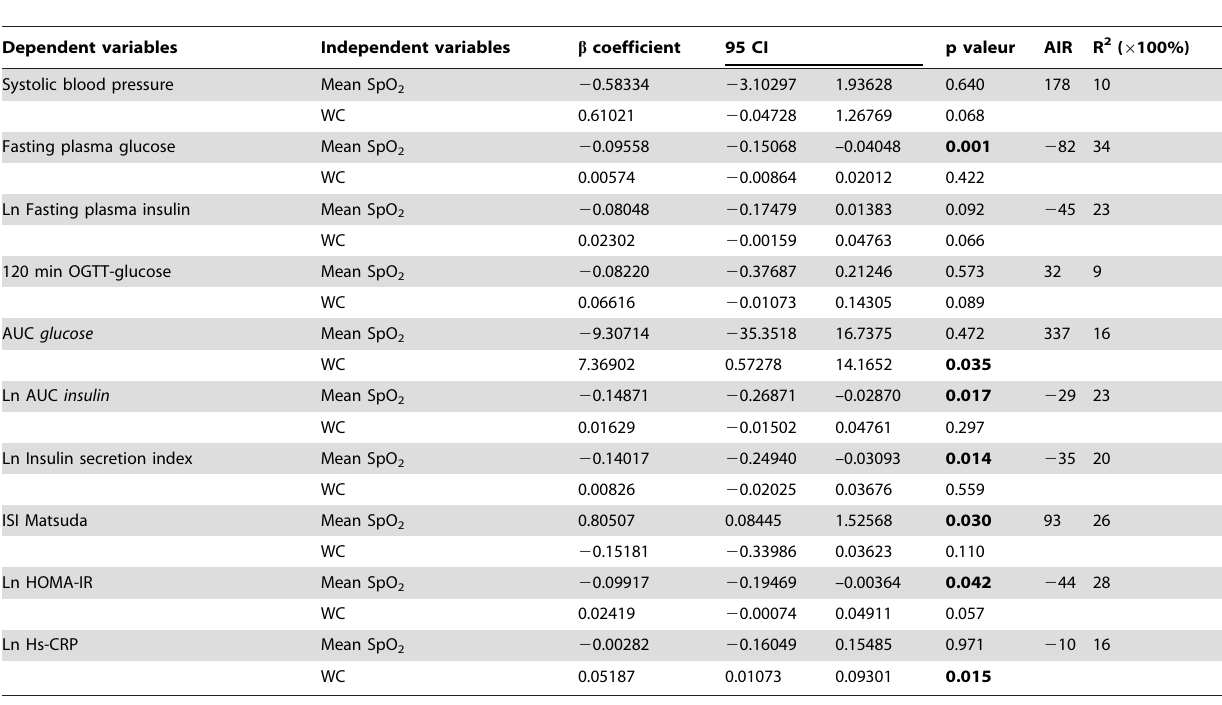
Table 3. Multivariable linear regression analyses: relative contribution of mean nocturnal SpO 2 and waist